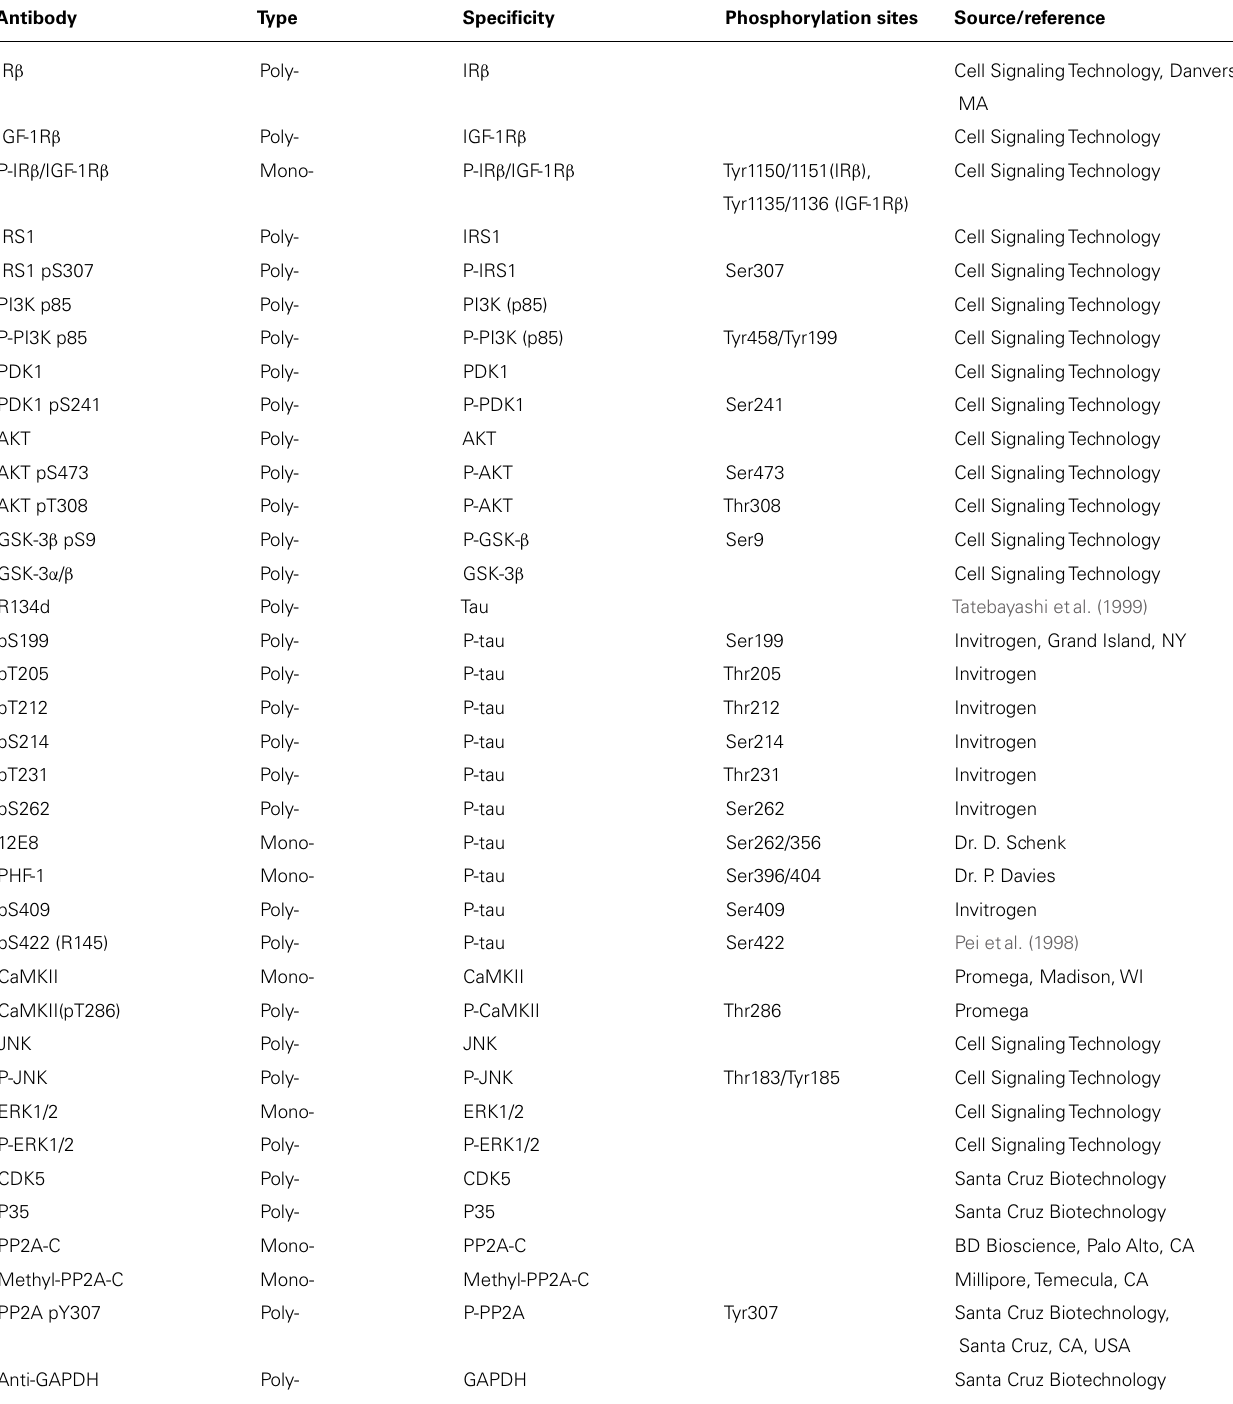
Table 1 | Primary antibodies used in this